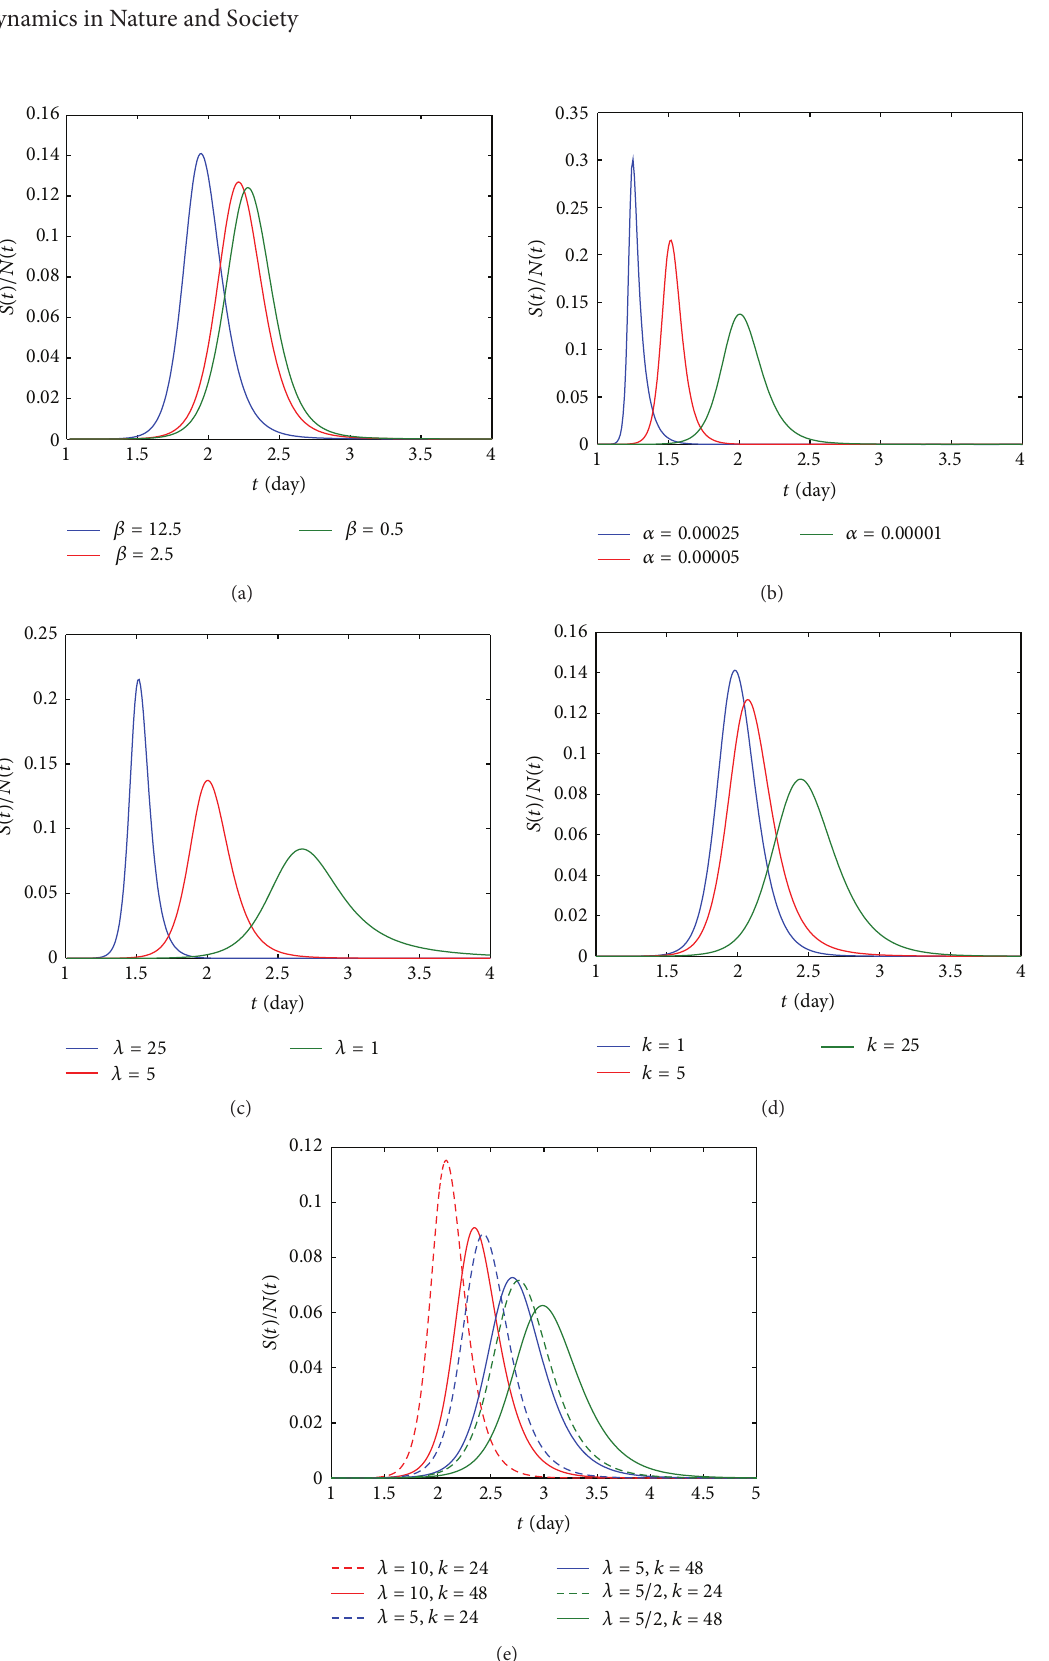
Figure 6: The proportion of spreader in terms of 𝛽, 𝛼,𝜆 , and 𝑘